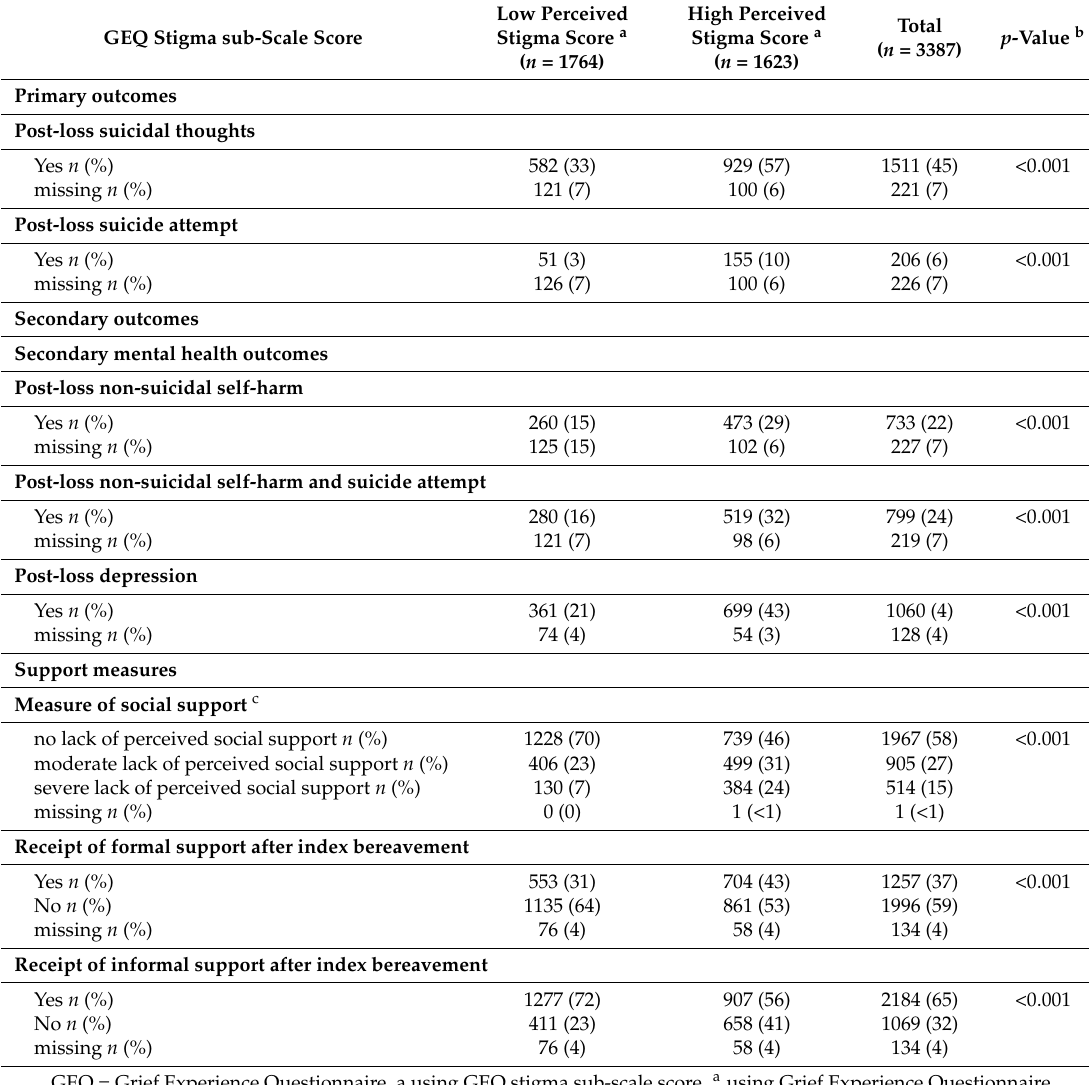
Table 2. Summary of outcomes by low versus high perceived stigma